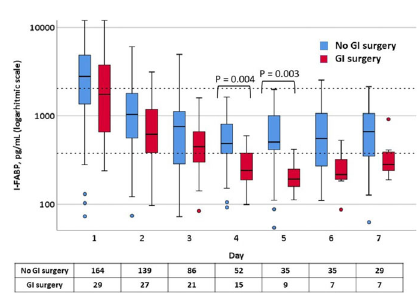
Fig. 4 (abstract 000698). Plasma I-FABP dynamics in GI vs no GI